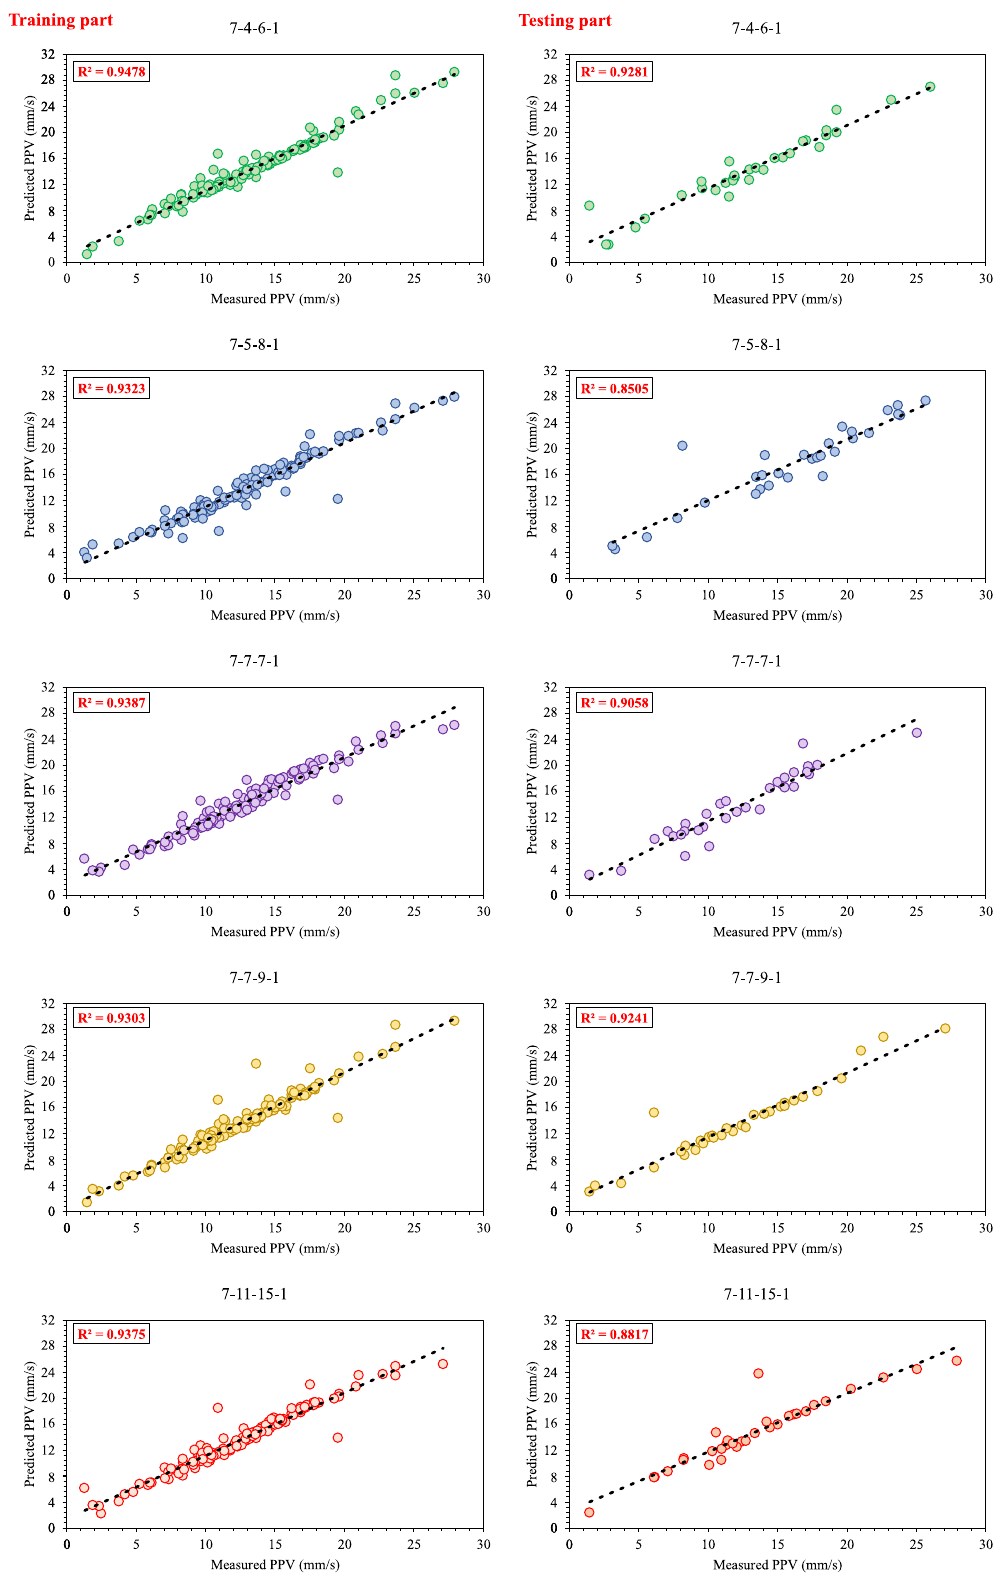
Figure 4. Correlation graph between measured and predicted values of PPV, using five top base models of